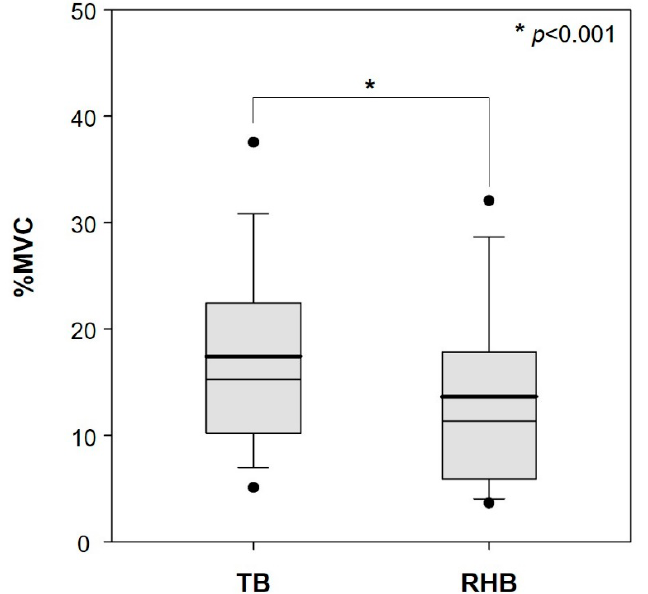
Figure 4. Comparison between the typical harvesting basket (TB) and the harvesting basket with attached the rotational handles (RHB) in terms of total muscle activity (bold line, arithmetic mean; circles, 5th/95th percentiles).